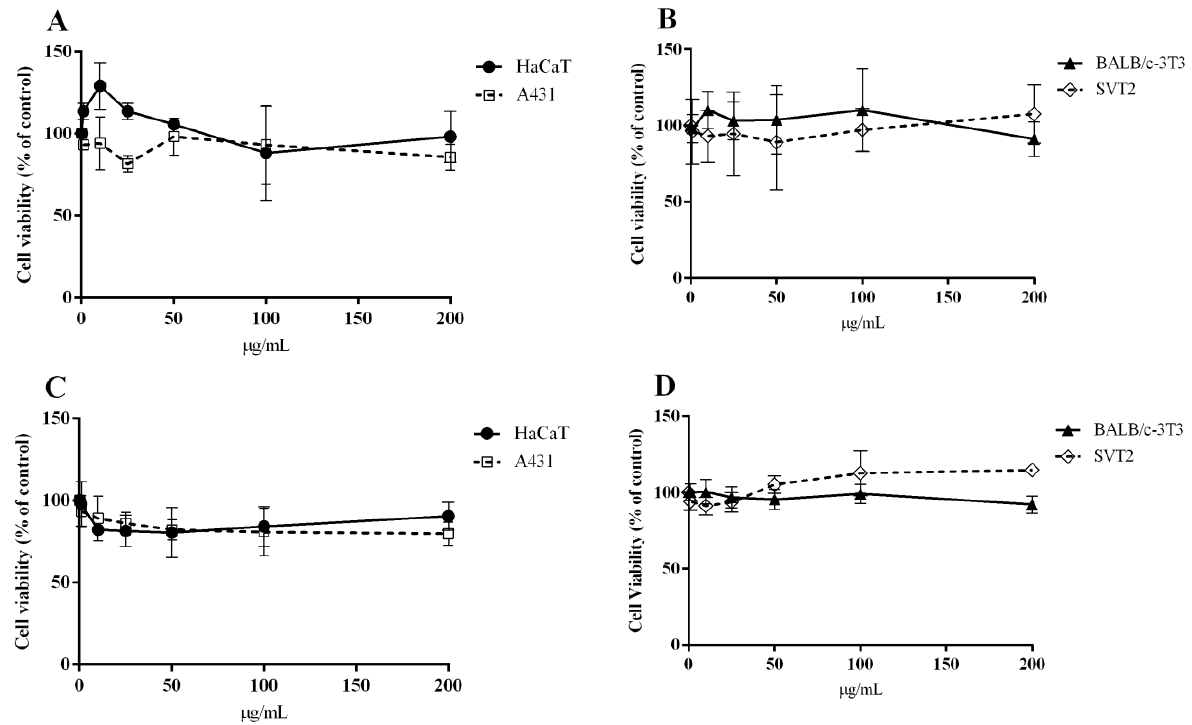
Figure 6. Effect of SPA-AgNPs and SPR-AgNPs on the viability of immortalized cells and cancer cells. Increasing concentrations (1–200 µ g/mL) of SPA-AgNP ( A , B ) or SPR-AgNP ( C , D ) nanoparticles were added to HaCaT (black circles), BALB/c-3T3 (black triangles), A431 (empty squares), or SVT2 (empty rhombuses) for 72 h. Cell viability was assessed by the MTT assay and cell survival was expressed as a percentage of viable cells in the presence of the nanoparticle under test with respect to the control cells grown in the absence of the nanoparticle. The data shown represent the means ± S.D. of three independent experiments.